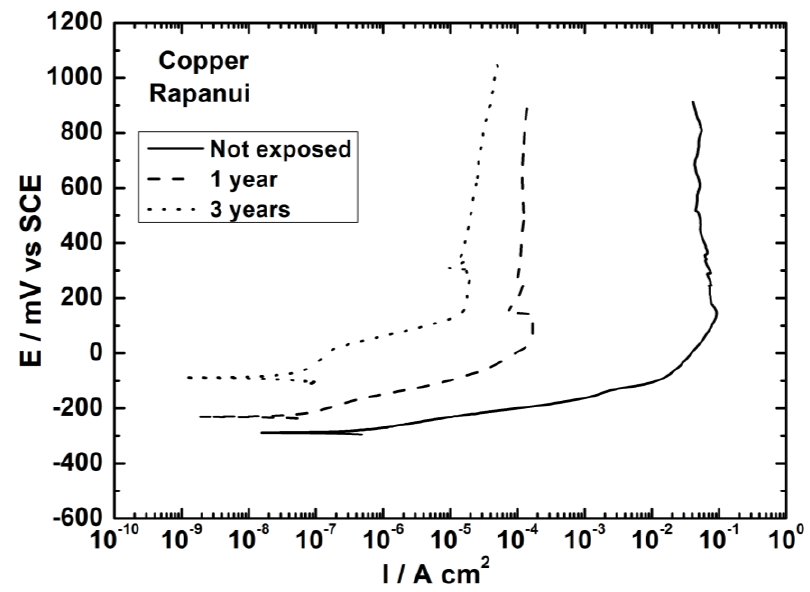
Figure 11. Anodic curves for unexposed copper at 1 and 3 years of exposure. Front side.